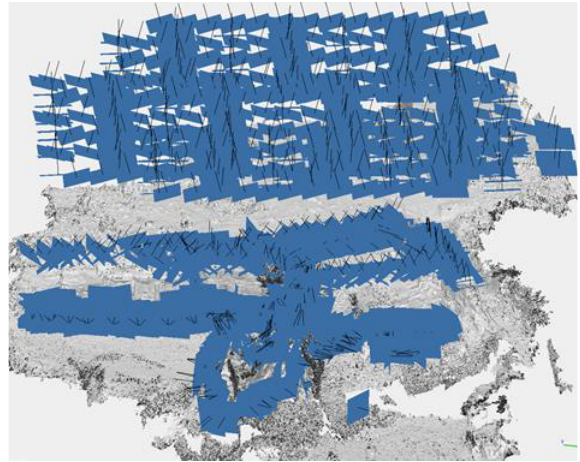
Figure 6 . The position of the oriented cameras at the